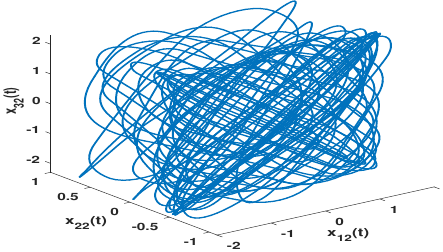
Figure 2. The chaotic trajectories of x i 2 ( t ) .